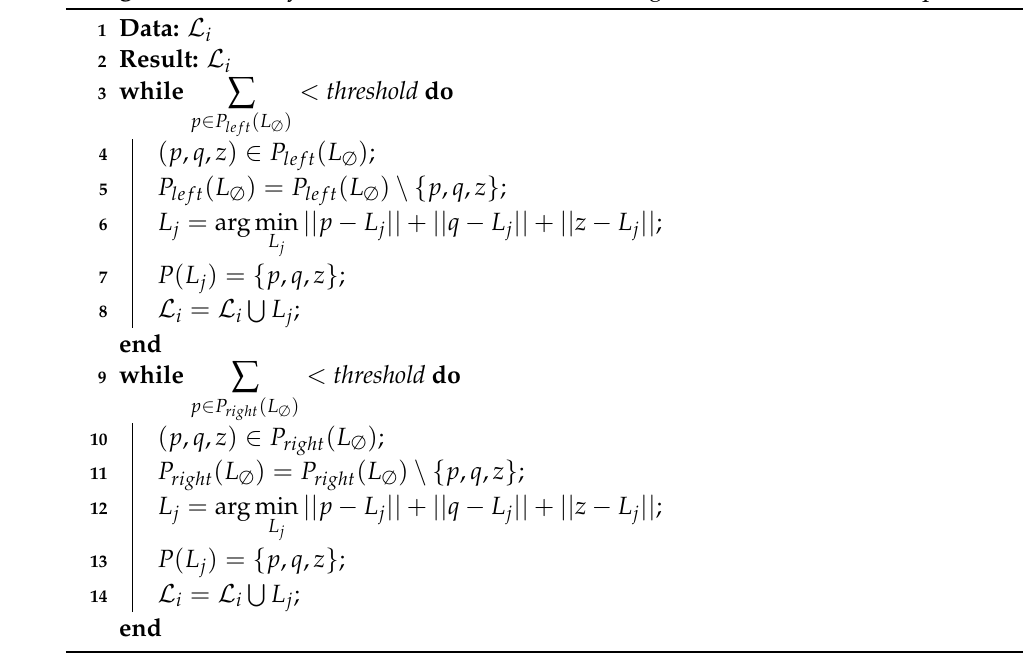
Algorithm 3: Ruby Genetic One Point Positive/Negative-Search models-step 1.